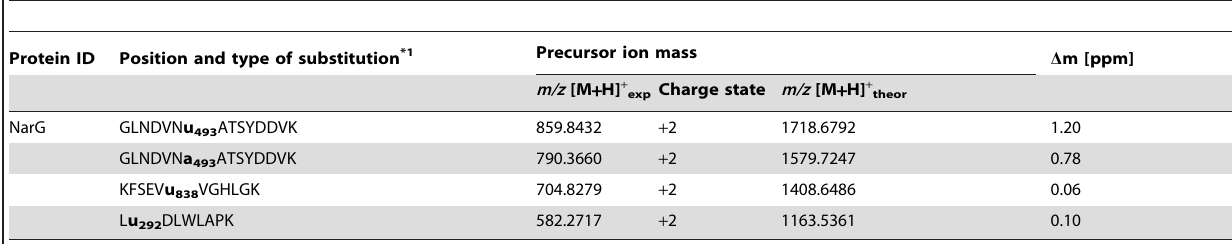
Table 4. Summary of peptides in the E. coli selC mutant, in which cysteines were found to be substituted by selenocysteine and converted to dehydroalanine during ESI-LTQ-Orbitrap-MS/MS.